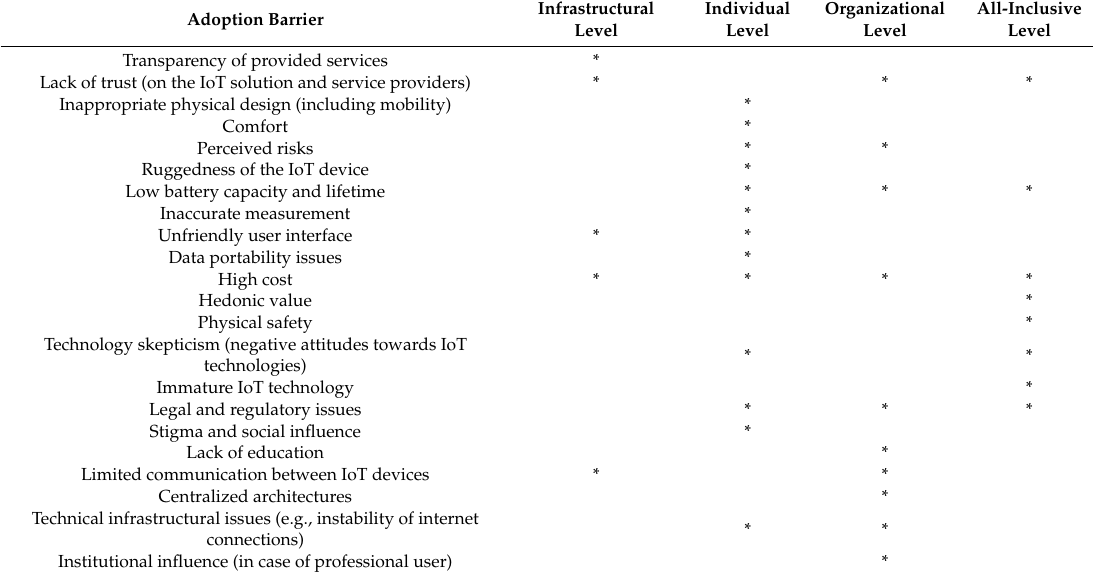
Table 2. Cont. Table 3. Summary of adoption barriers at four application levels of internet of things